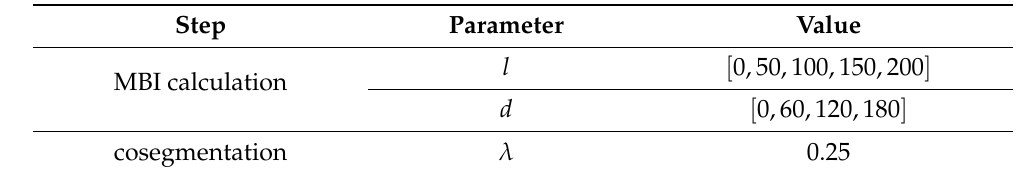
Table 2. Parameter